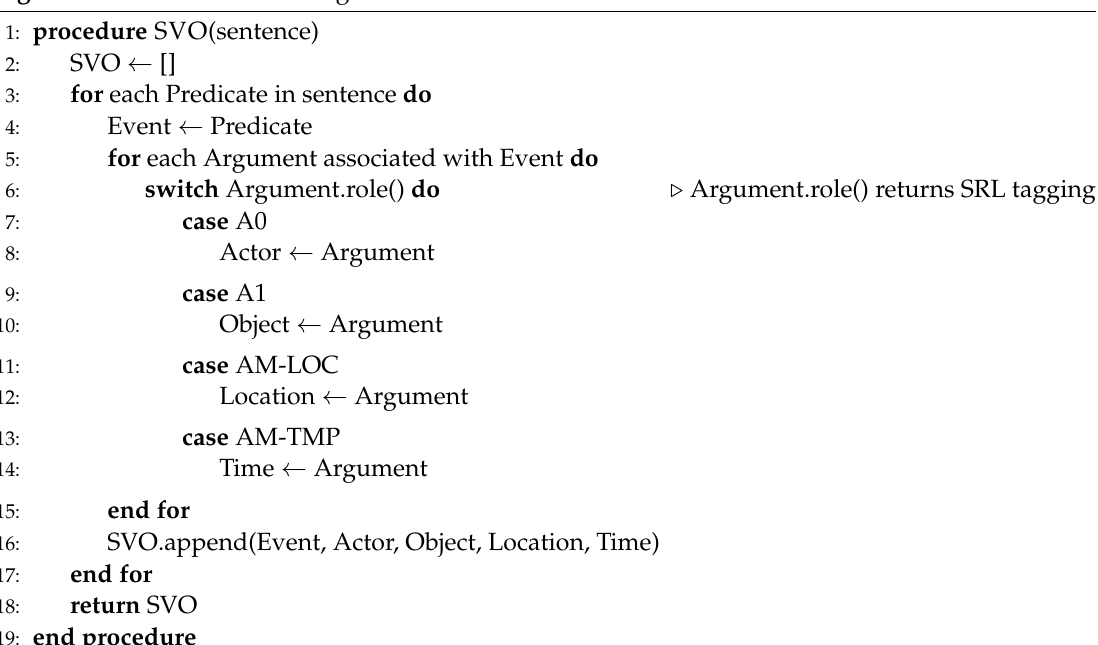
Algorithm 1 SVO Extraction